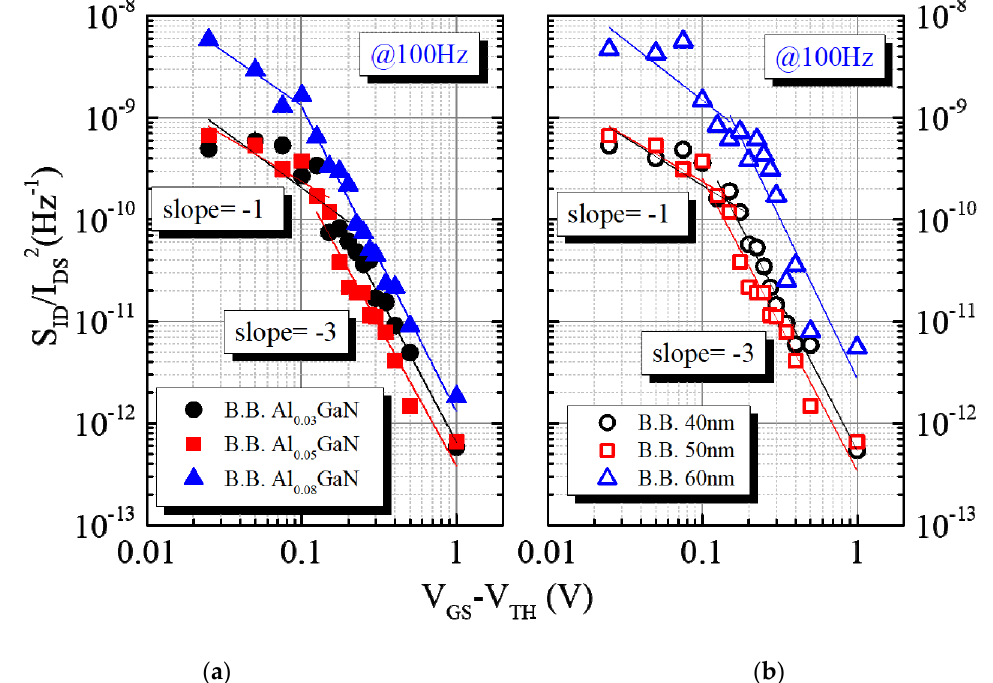
Figure 6. The measured of low frequency noise of devices. ( a ) the different Al mole fraction; ( b ) the different thickness of B.B. devices.